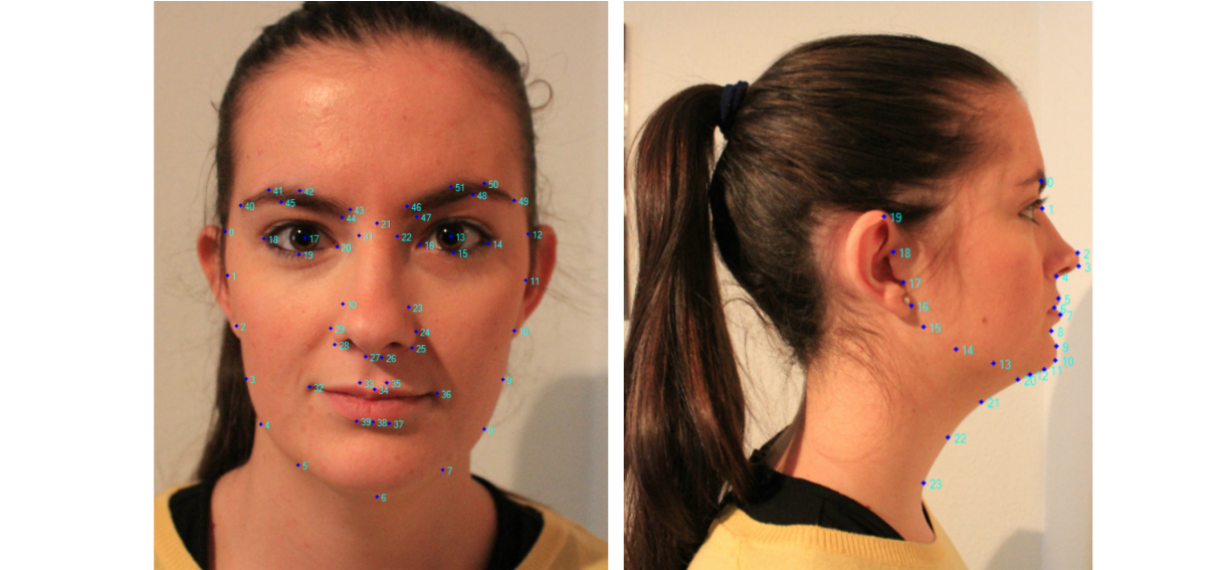
Figure 2. Landmarks on frontal and profile